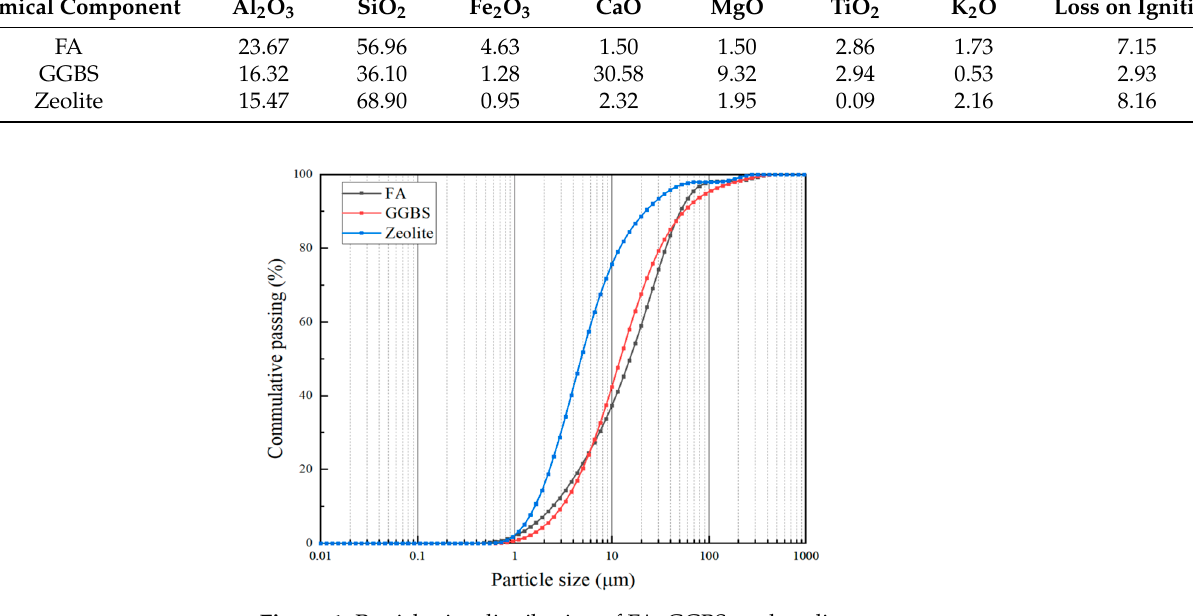
Figure 1. Particle size distribution of FA, GGBS, and zeolite. Table 2. Chemical composition of water glass.